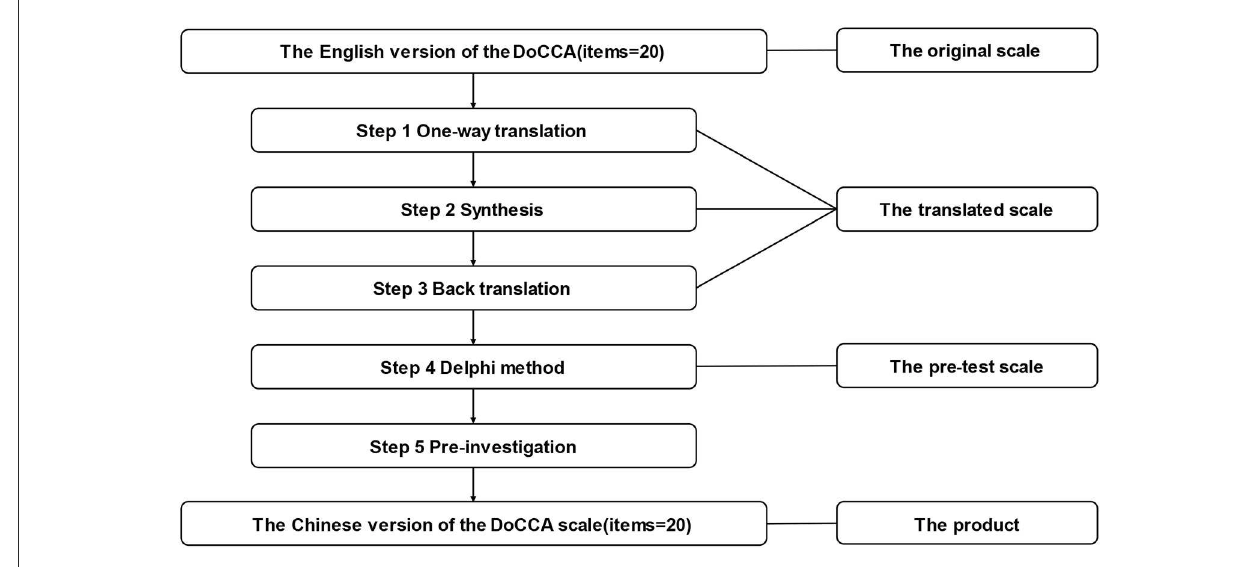
FIGURE1 Scale translation procedure for Chinese DoCCA scale.